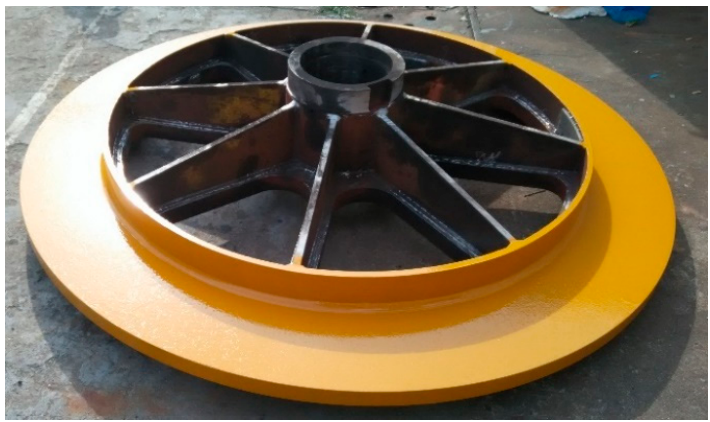
Figure 8. Practicality picture of thick steel disc.